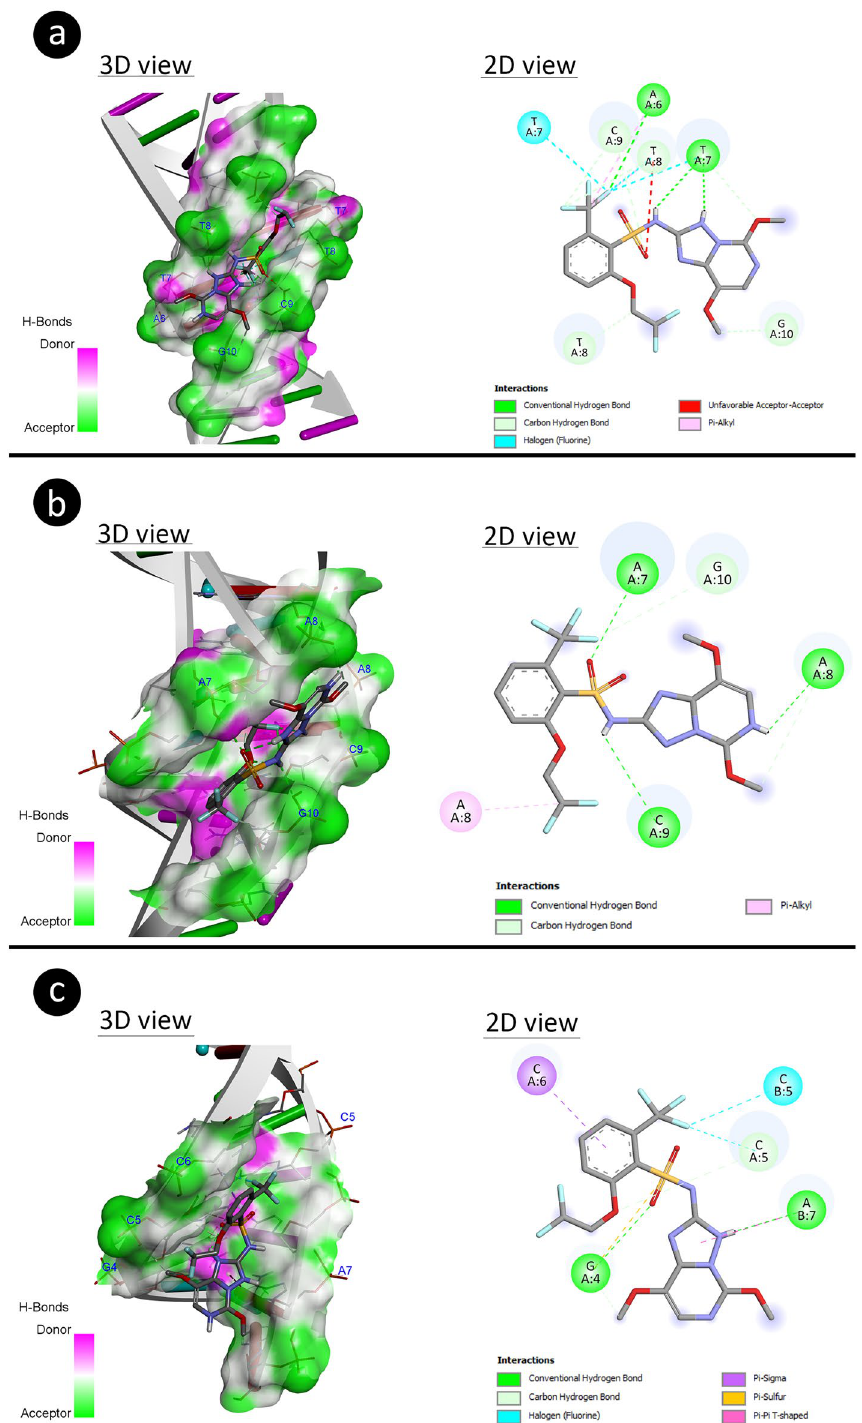
Figure 7. The structural interaction of penoxsulam with DNA ( a 1BNA, b 195D, c